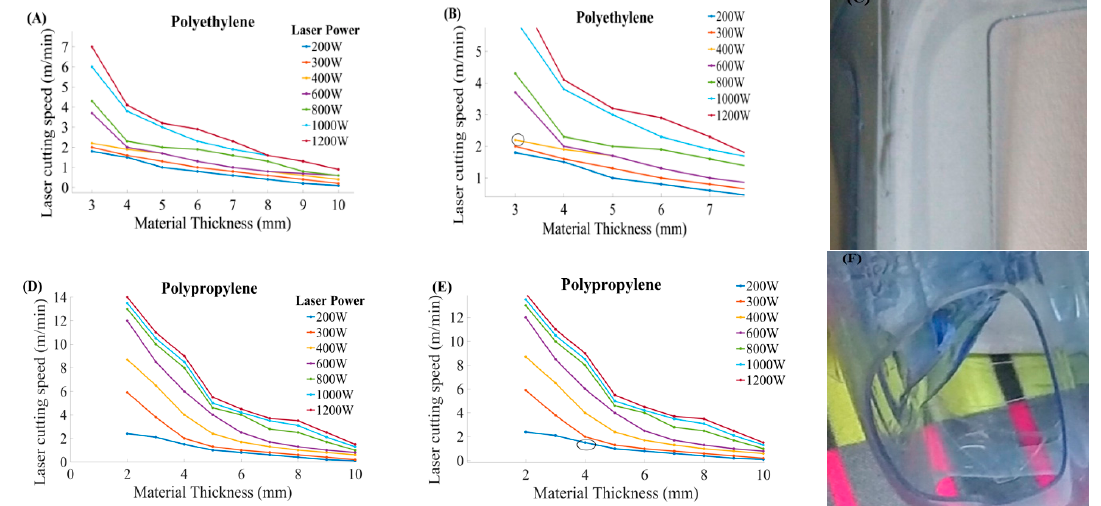
Figure 10. Parametric trends for CS and depth of cut (DOC) at different power ratings in PMMA [46]. PE and PP material were cut at a different material thickness. It was observed that the thick workpiece needed high CS while the thin material needed less speed, as illustrated in Figure 11. Controlled CS is required to cut different thickness that leads to obtaining good cut quality.